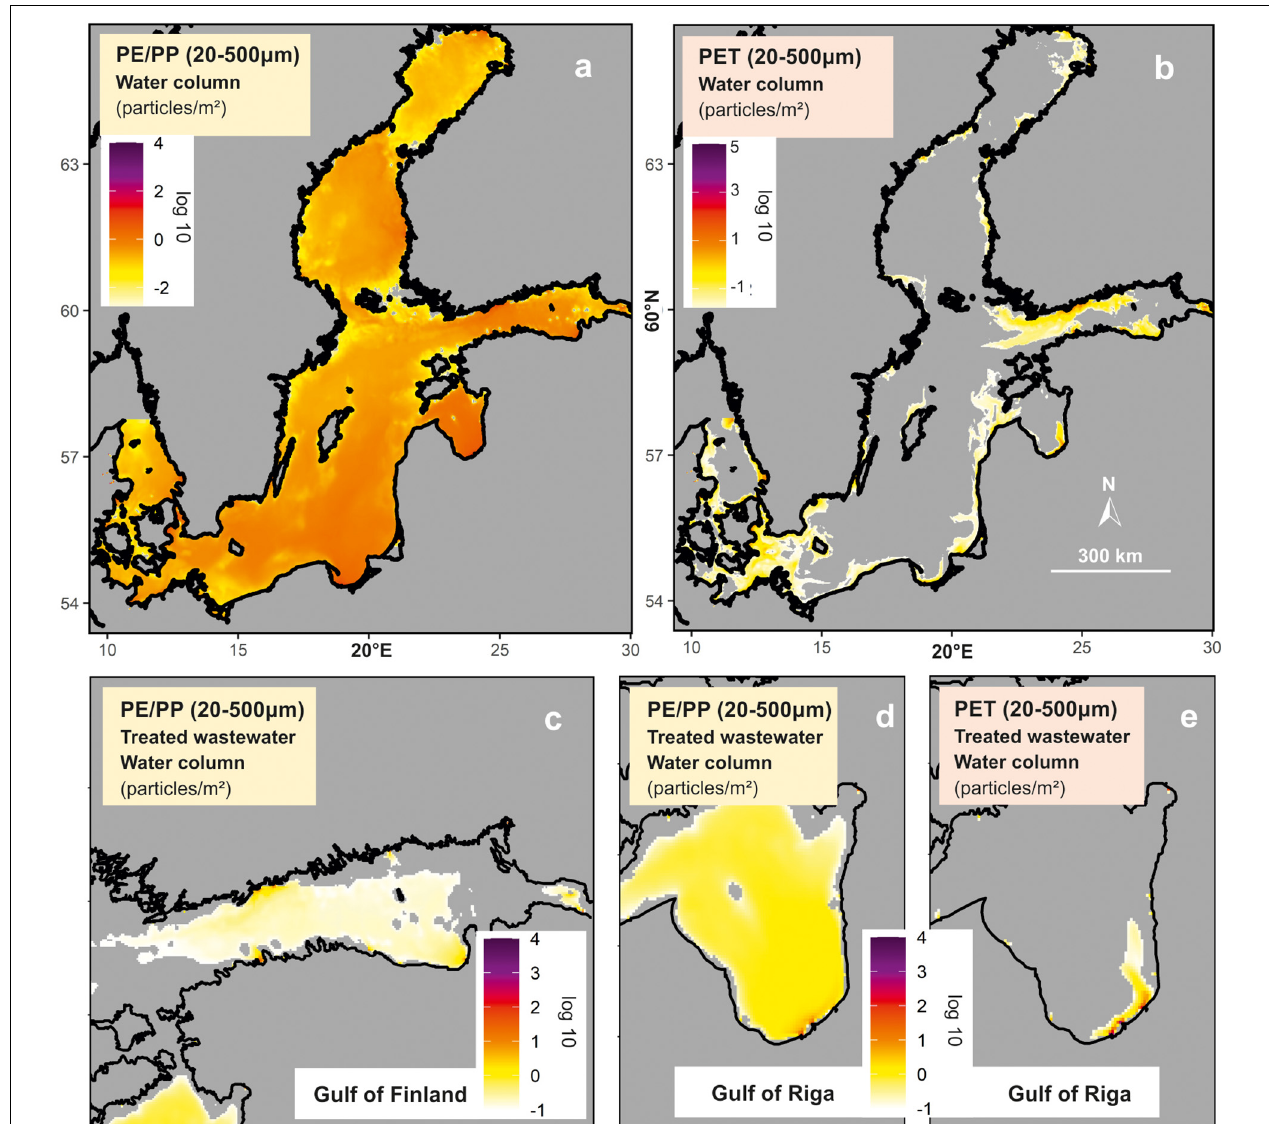
FIGURE 5 | Spatial concentration of Polyethylene (PE)/Polypropylene (PP) (a) and Polyethylenterephthalat (PET) (b) microplastic particles (20–500 µ m size fraction) in the water column of the Baltic Sea and in selected sub-basins (c–e) based on simulations with a 3D hydrodynamic model. PE/PP represents floating and PET sinking plastic. The emissions cover all three urban sources. Gray areas in the sea indicate concentration below the color scale.